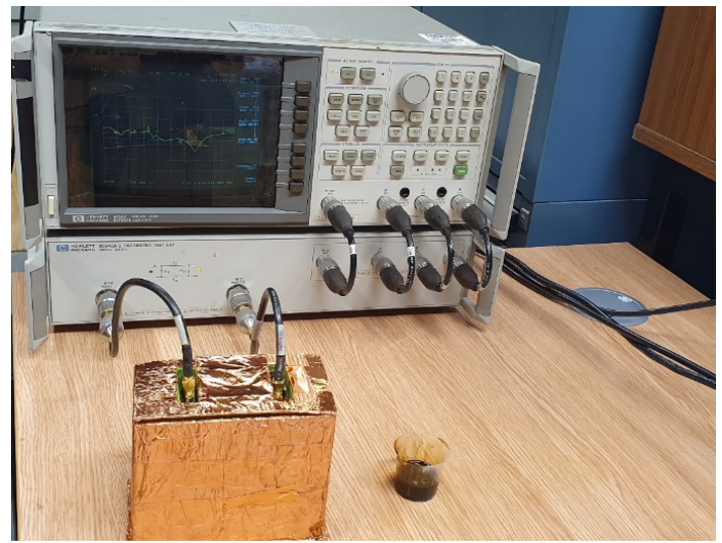
Figure 3. Experimental setup for the oil spill test for crude oil.